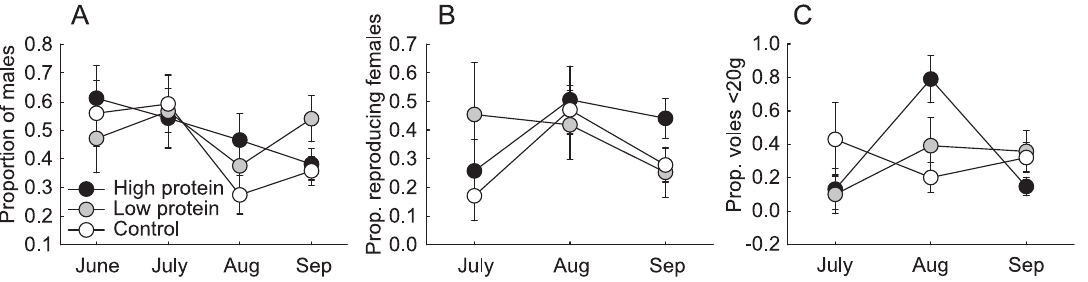
Figure 3. Demographic attributes of experimental populations (least squared mean ± se). (A) proportion of males in total population, (B) proportion of reproducing (pregnant and/or lactating) females in total female population, (C) proportion of voles , 20 g from total population.